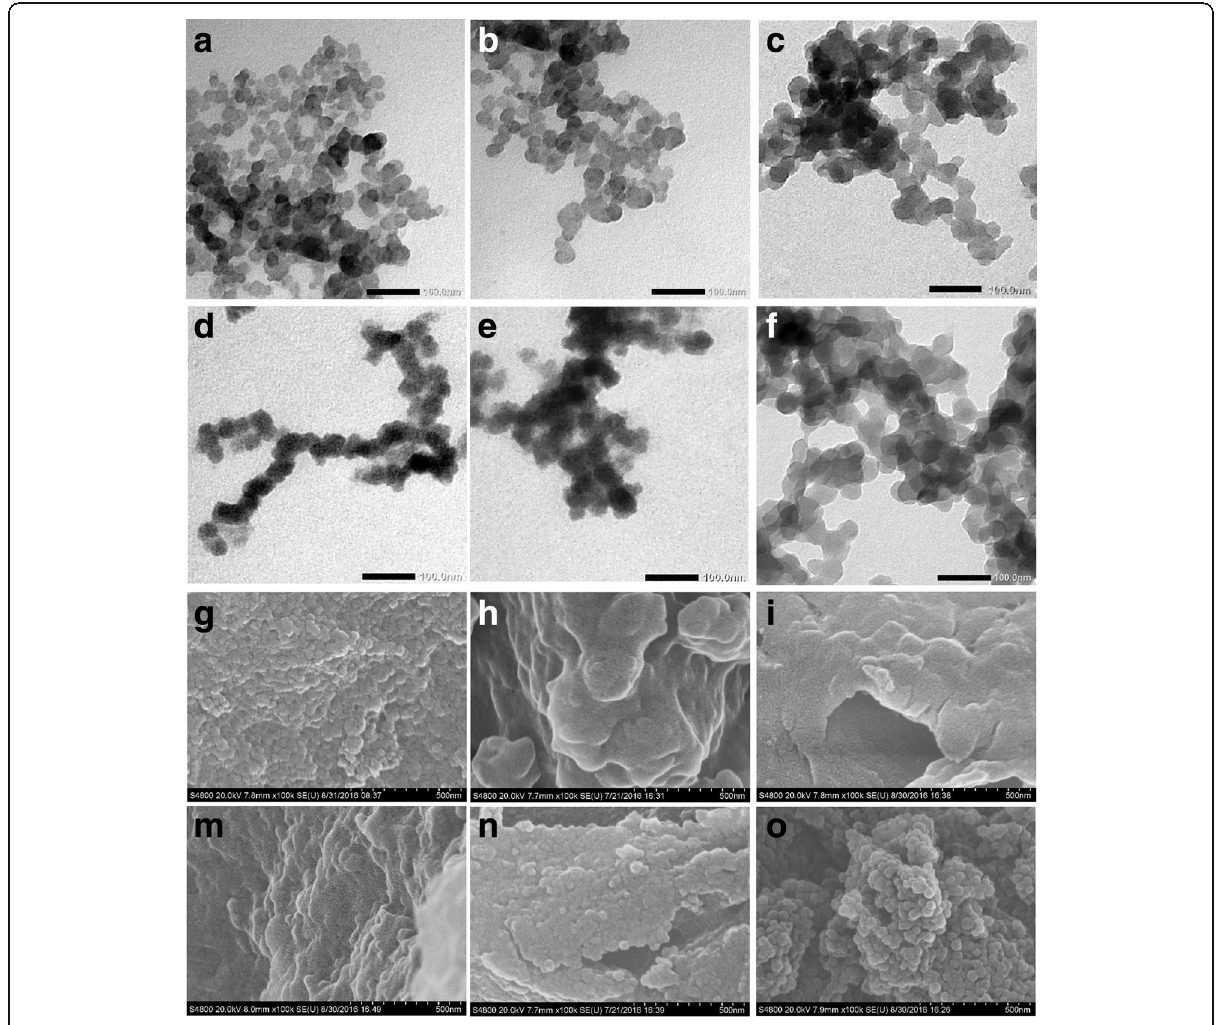
Fig. 1 TEM ( a – f ) and SEM ( g – o ) images of pure PS and PS/PANI-LSA nanocomposites: a , g - pure PS; b , h - NC2; c , i - NC3; d , m - NC6; e , n - NC11 and f , o -